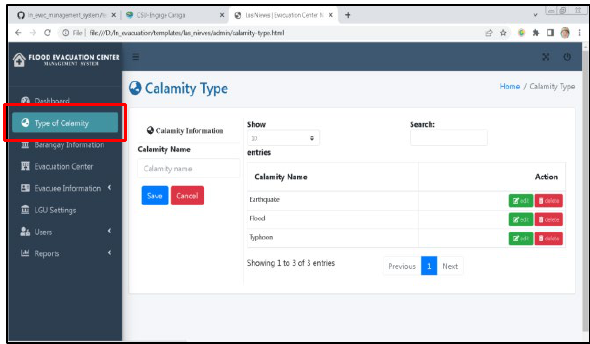
Figure 16. Form of the Calamity Type of the System